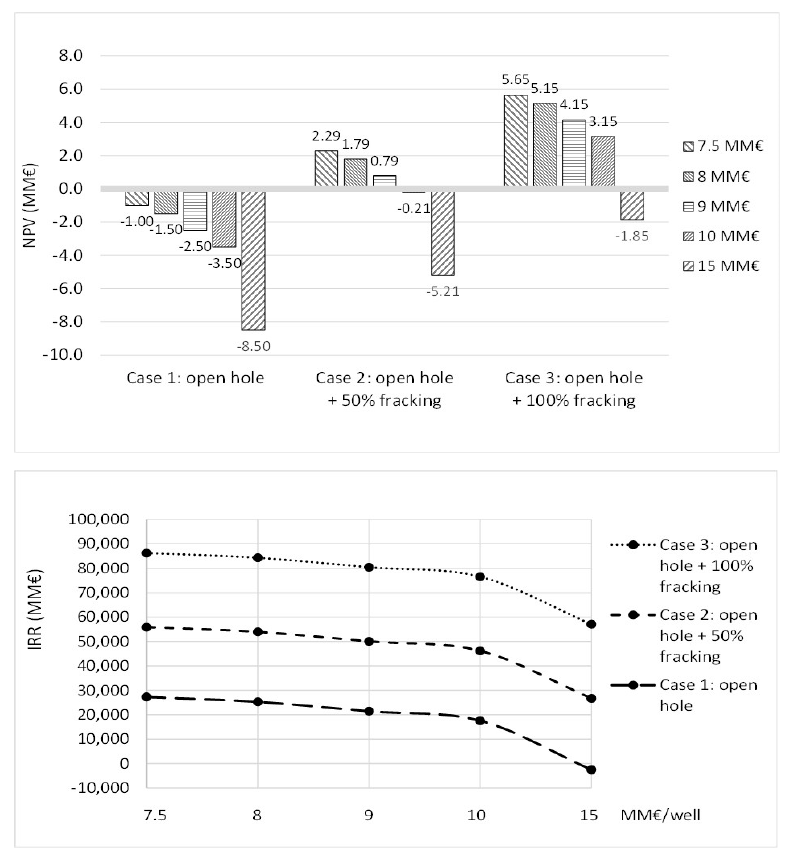
Figure 8. NPV (Net Present Value) and IRR (Internal Rate of Return) of the